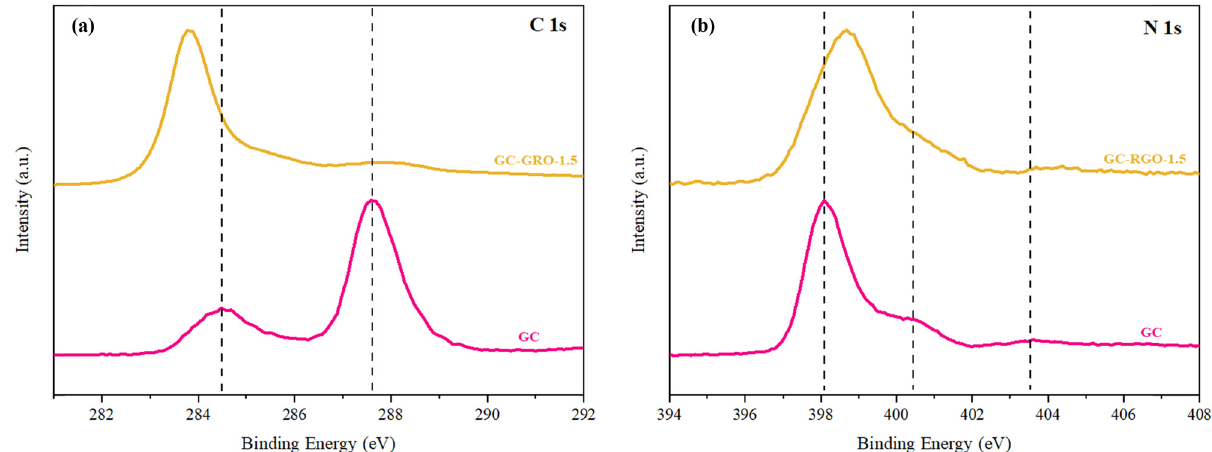
Figure 4: The XPS spectrum of GC and GC - RGO - 1.5: ( a ) C 1s and ( b ) N